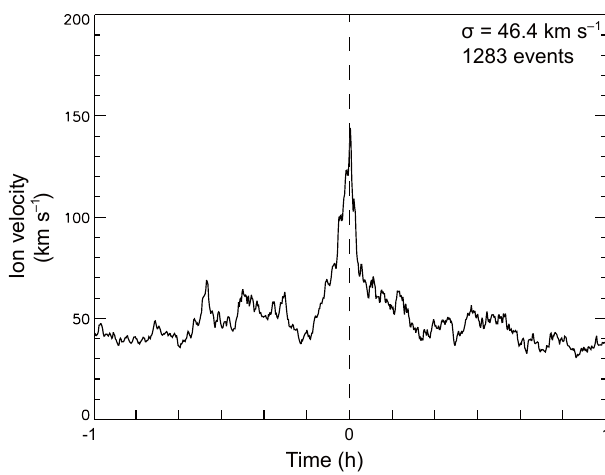
Figure 11. Distribution of 10s averaged ion velocities during mag- netic fluctuation events. Figure 12. Superposed epoch analysis of ion velocity 1h before and after the time of severe magnetic fluctuation